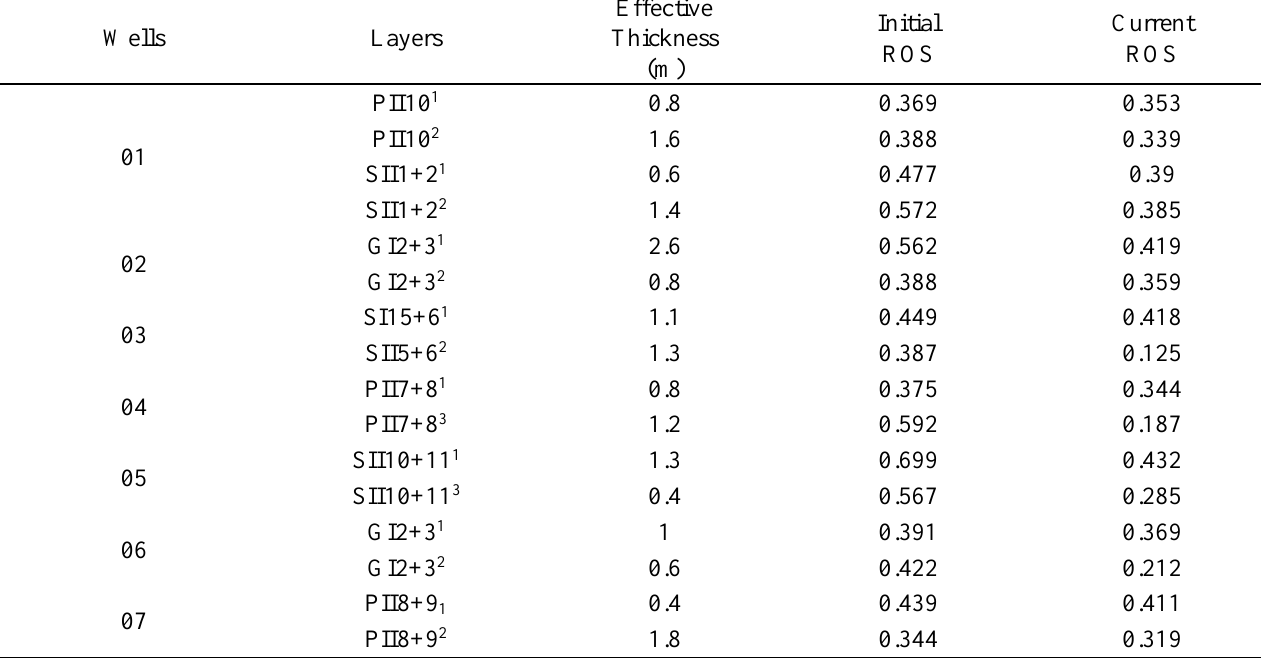
Table 4—Three-dimensional ROS calculation